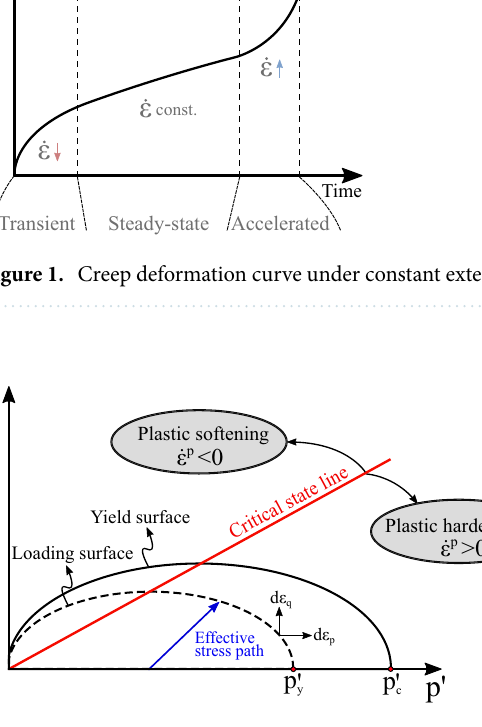
Figure 2. The illustration shows the schematic of the MCC model in the stress space. It indicates how the yield surface develops, depending on the effective stress path, highlighting the plastic hardening (below the CSL) and the plastic softening region (above the